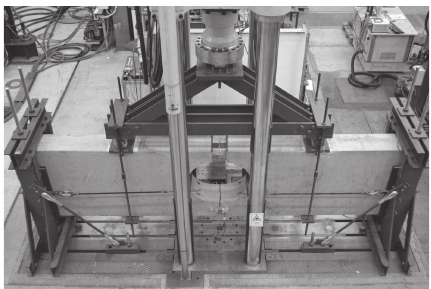
Figure 1: Photograph of the experimental setup.